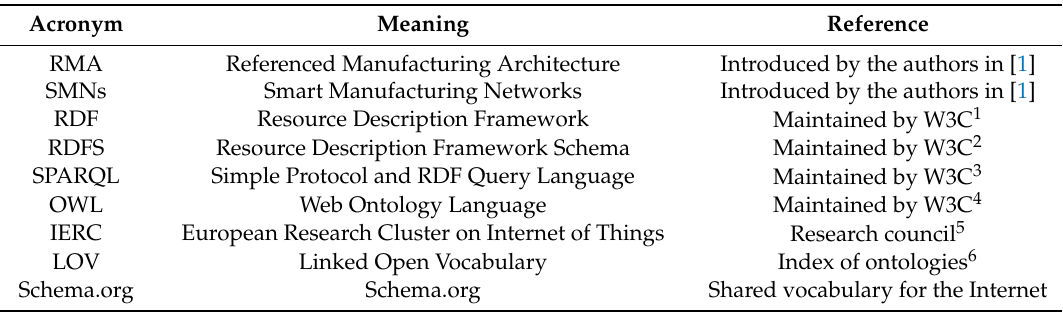
Table 2. List of acronyms and relevant technologies for structured and unstructured knowledge